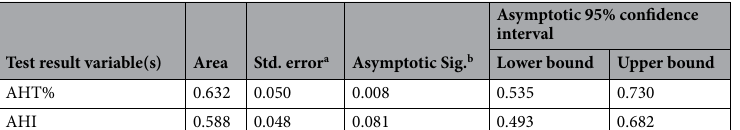
Test result variable(s) Area